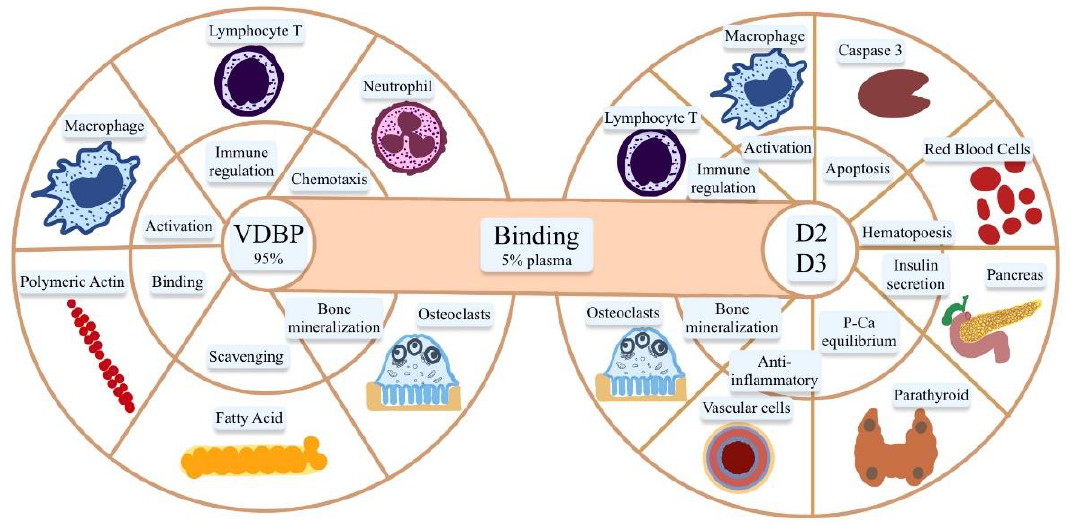
Figure 4. The roles of vitamin D2 and D3 and VDPB. Only 5% of VDBP is found in plasma, bound by 25(OH)D, the main active metabolite of VD2 and VD3 subunits. The rest of the 95% is found in